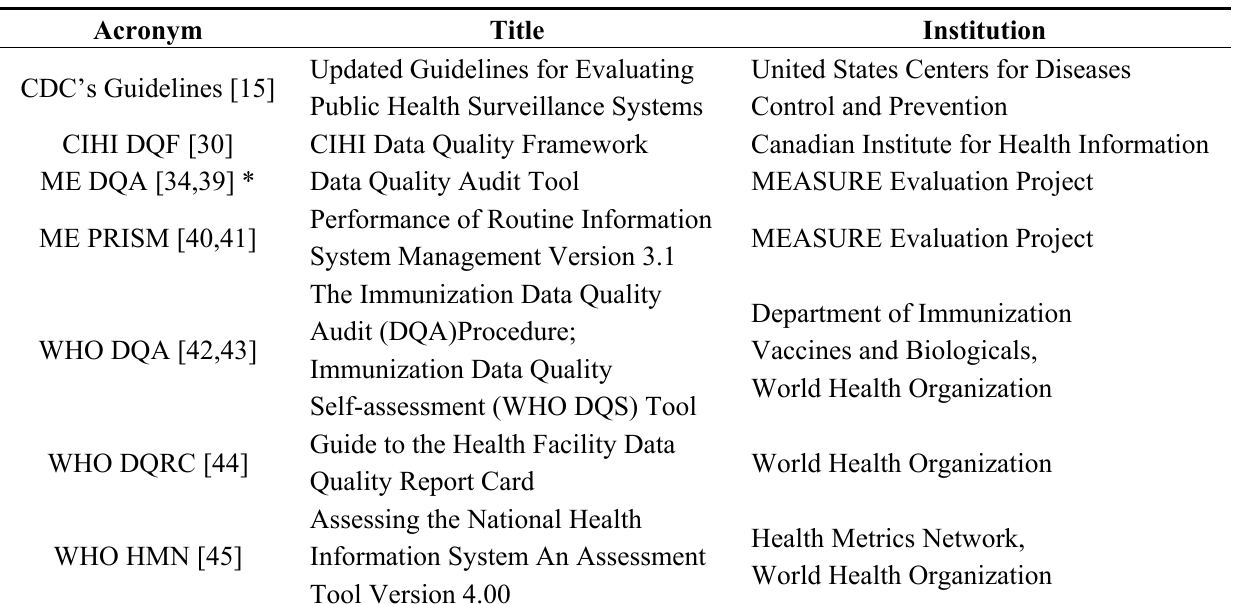
Table 1. Institutional data quality assessment